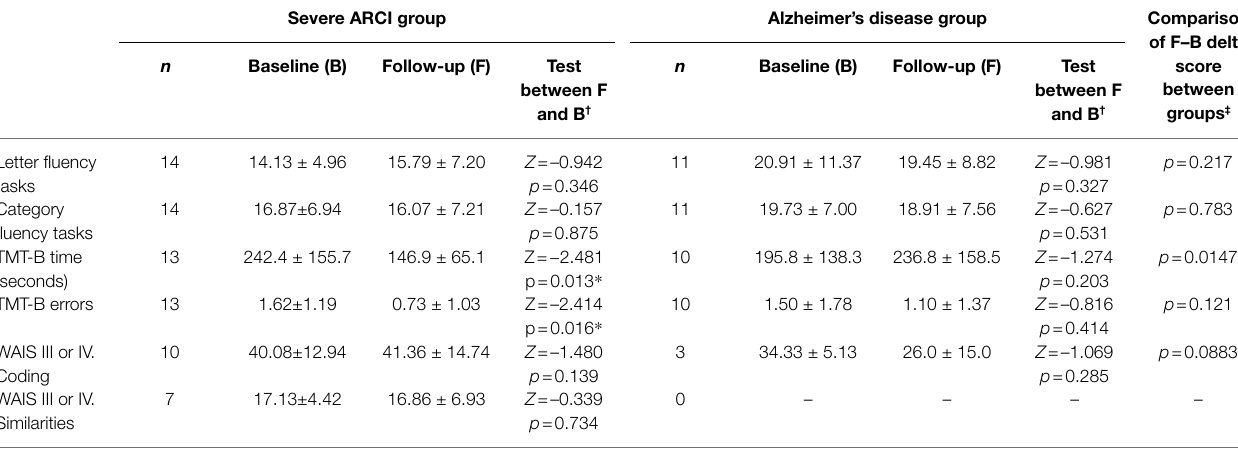
TABLE 3 | Results of cognitive tests of executive functions at baseline (B) and follow-up (F) in severe Alcohol-Related Cognitive Impairment (severe ARCI) group ( n = 15) and in Alzheimer’s disease group ( n = 12). Severe ARCI group Alzheimer’s disease group Comparison